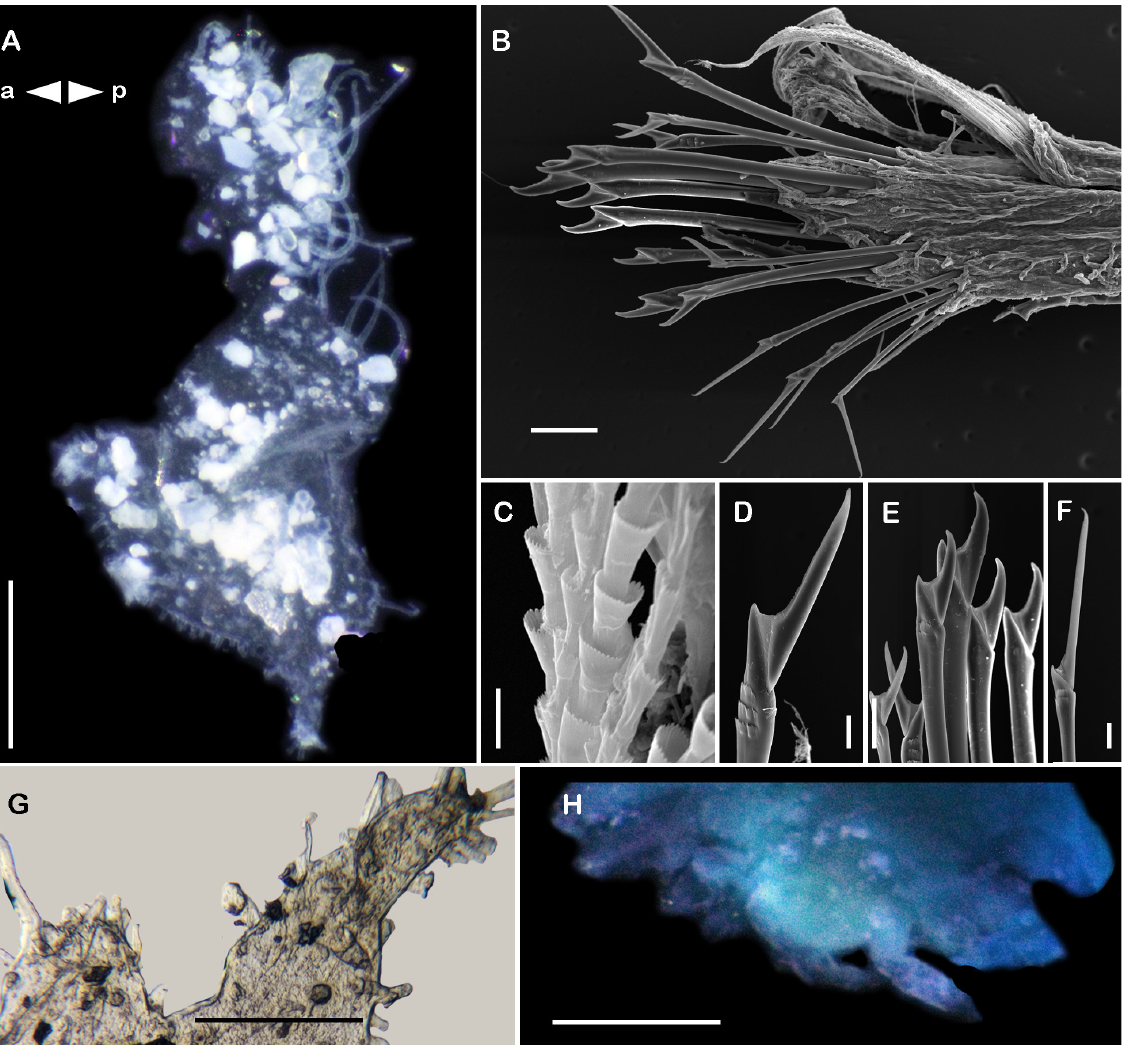
Fig. 14. Pelogenia brevipalpata sp. nov. B–F. SEM micrographs. Holotype (ECOSUR 289). A . Posterior damaged elytron. B . Right parapodium from segment 28. C . Notochaetae from same. D . Unit A. E . Units C and subunit 1. F . Unit D. G . Close-up from A, median margin. H . Pygidium. Abbreviations: a = anterior; p = posterior. Scale bars: A, H = 500 μm; B, G = 100 μm; C = 10 μm; D, F = 20 μm; E = 50